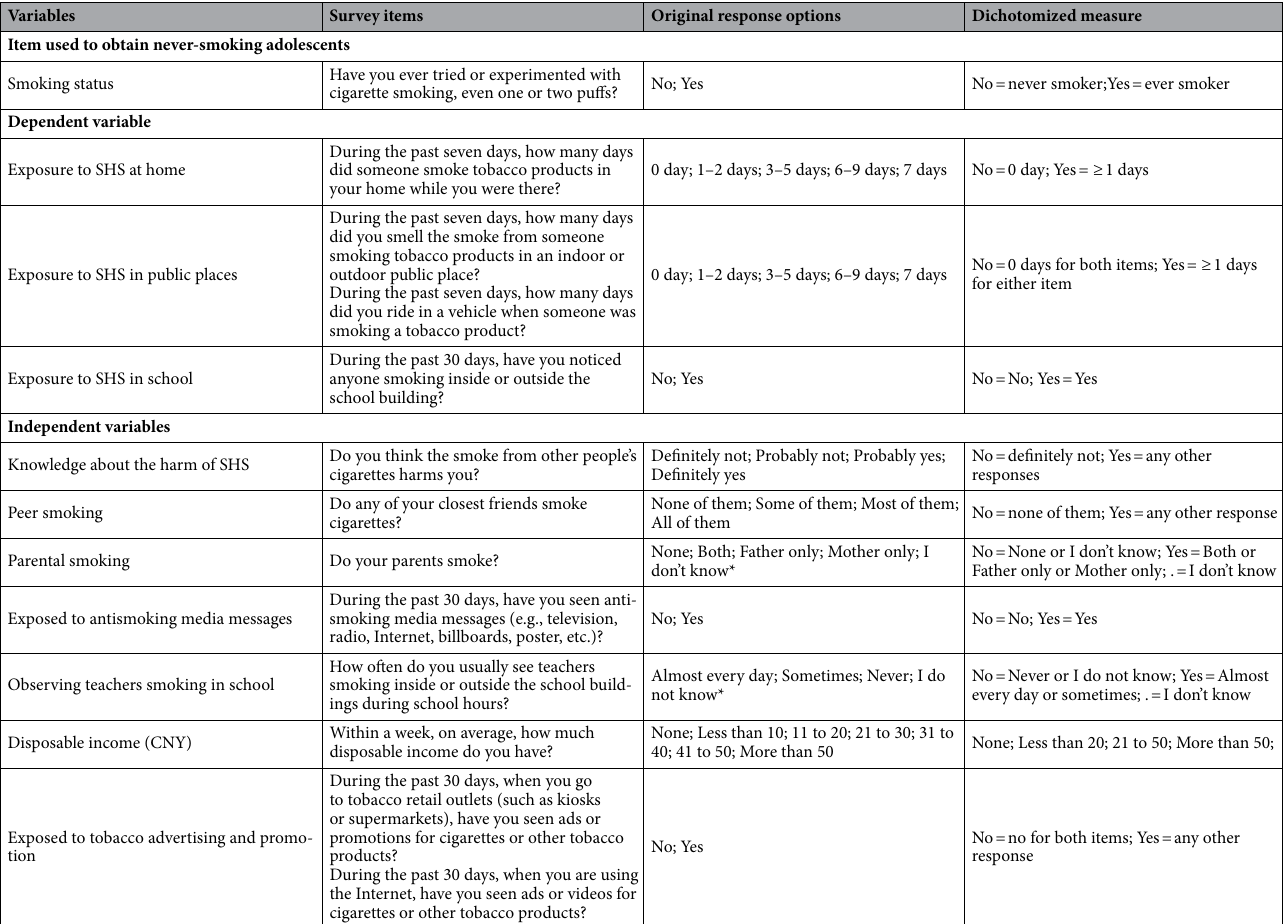
Table 1. Question-wording, response options and coding. “No” responses were coded as “0” and “Yes” responses as “1” for the multivariable logistic regression model. SHS secondhand smoke, CNY Chinese Yuan, 1 United States dollar = 6.7 Chinese yuan. *Set “I don’t know” as missing